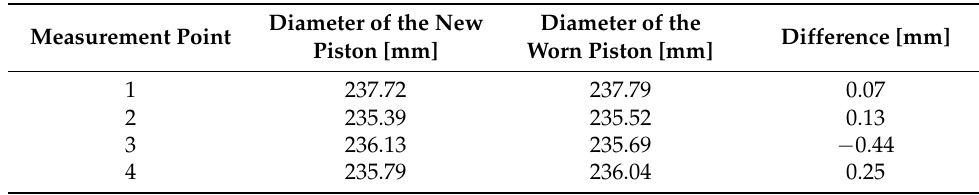
Table 1. Difference in the dimensions at the individual circumferences of the new and the worn